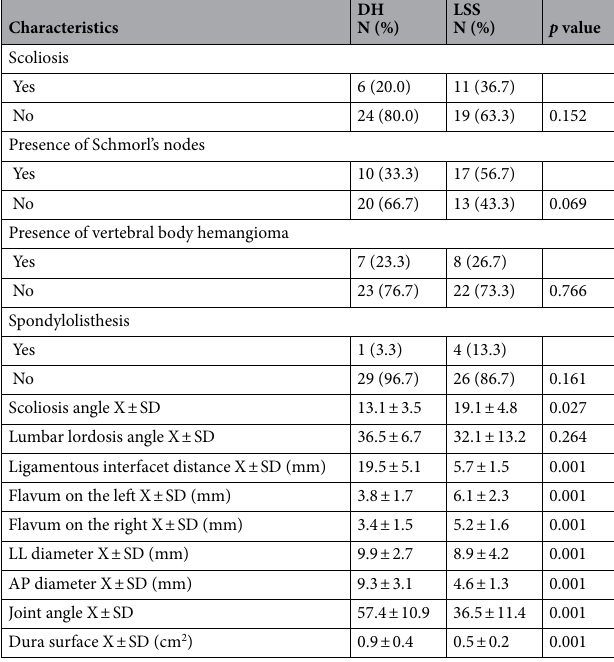
Table 3. Morphological/radiological parameters of patients included in the